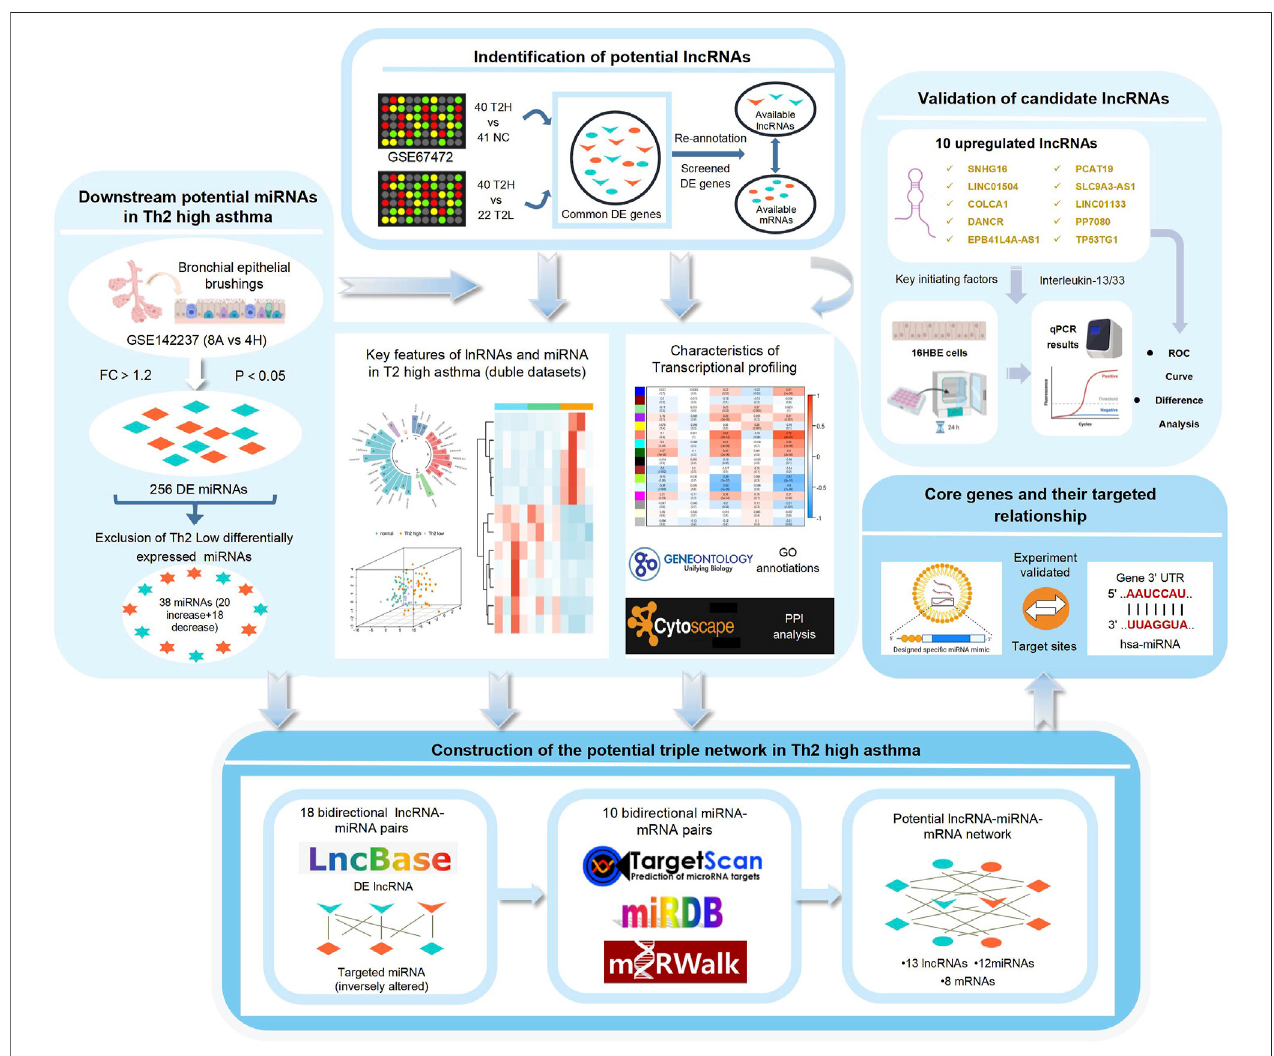
FIGURE 1 | The fl ow chart of the